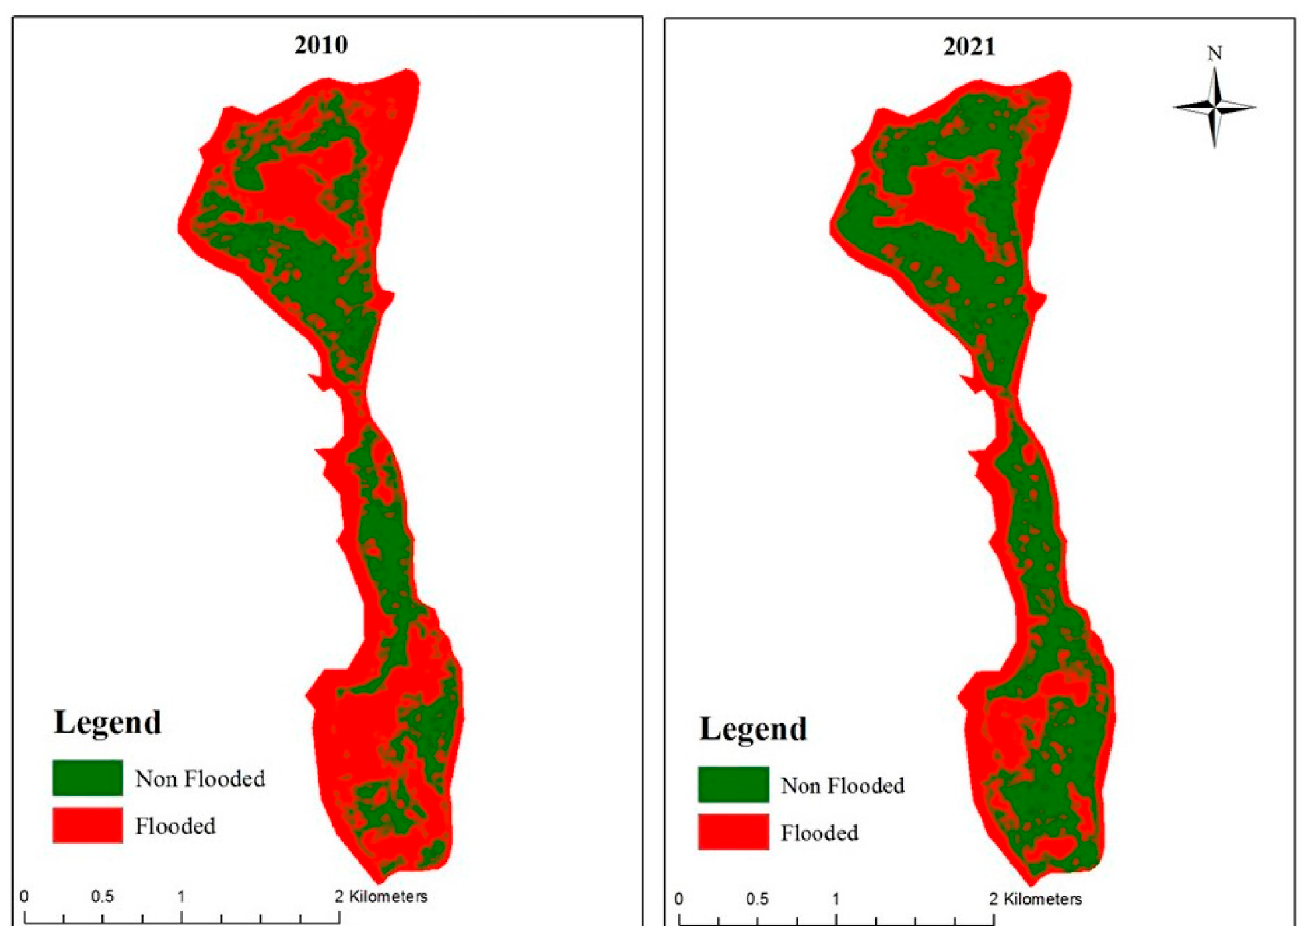
Figure 9. Flooded areas in percentage for different surge heights.